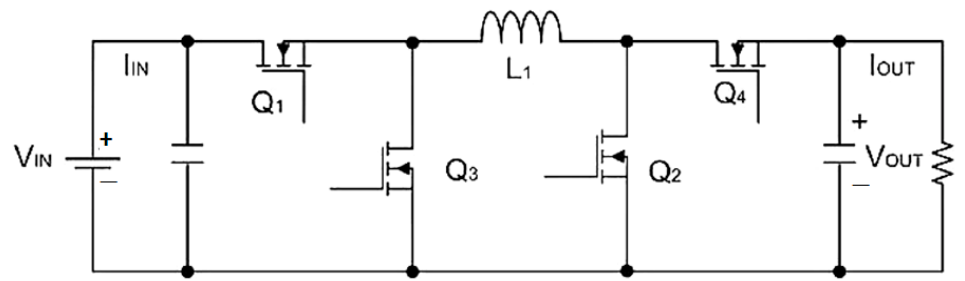
Figure 8. Schematic of a two-switch buck-boost converter: MOSFETs Q1 and Q2 share a gate-control signal and switch on and off at the same time in buck-boost mode.